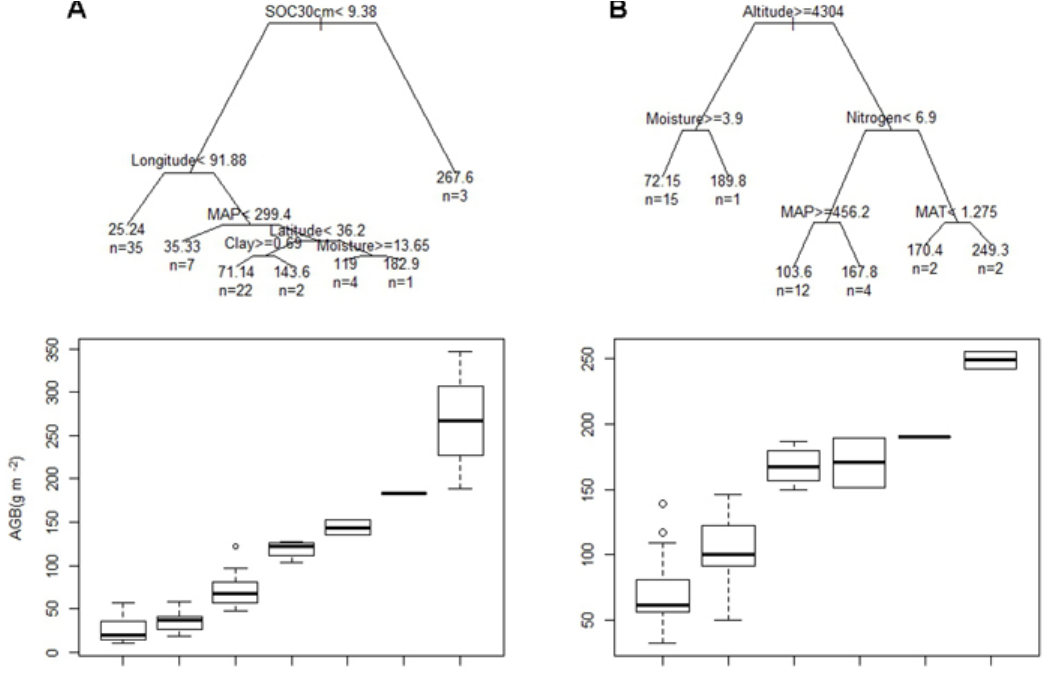
Fig. 3. CART analyses of the relationships between AGB abundance and environmental factors in the alpine steppe (A) and the alpine meadow (B) . The environmental factors are indicated in the graph by the screening in the higher panel. In the lower panel, the box-plots represent the deviation of AGB under the corresponding environmental factors in the children nodes. All designations are the same as those in the footnotes below Table